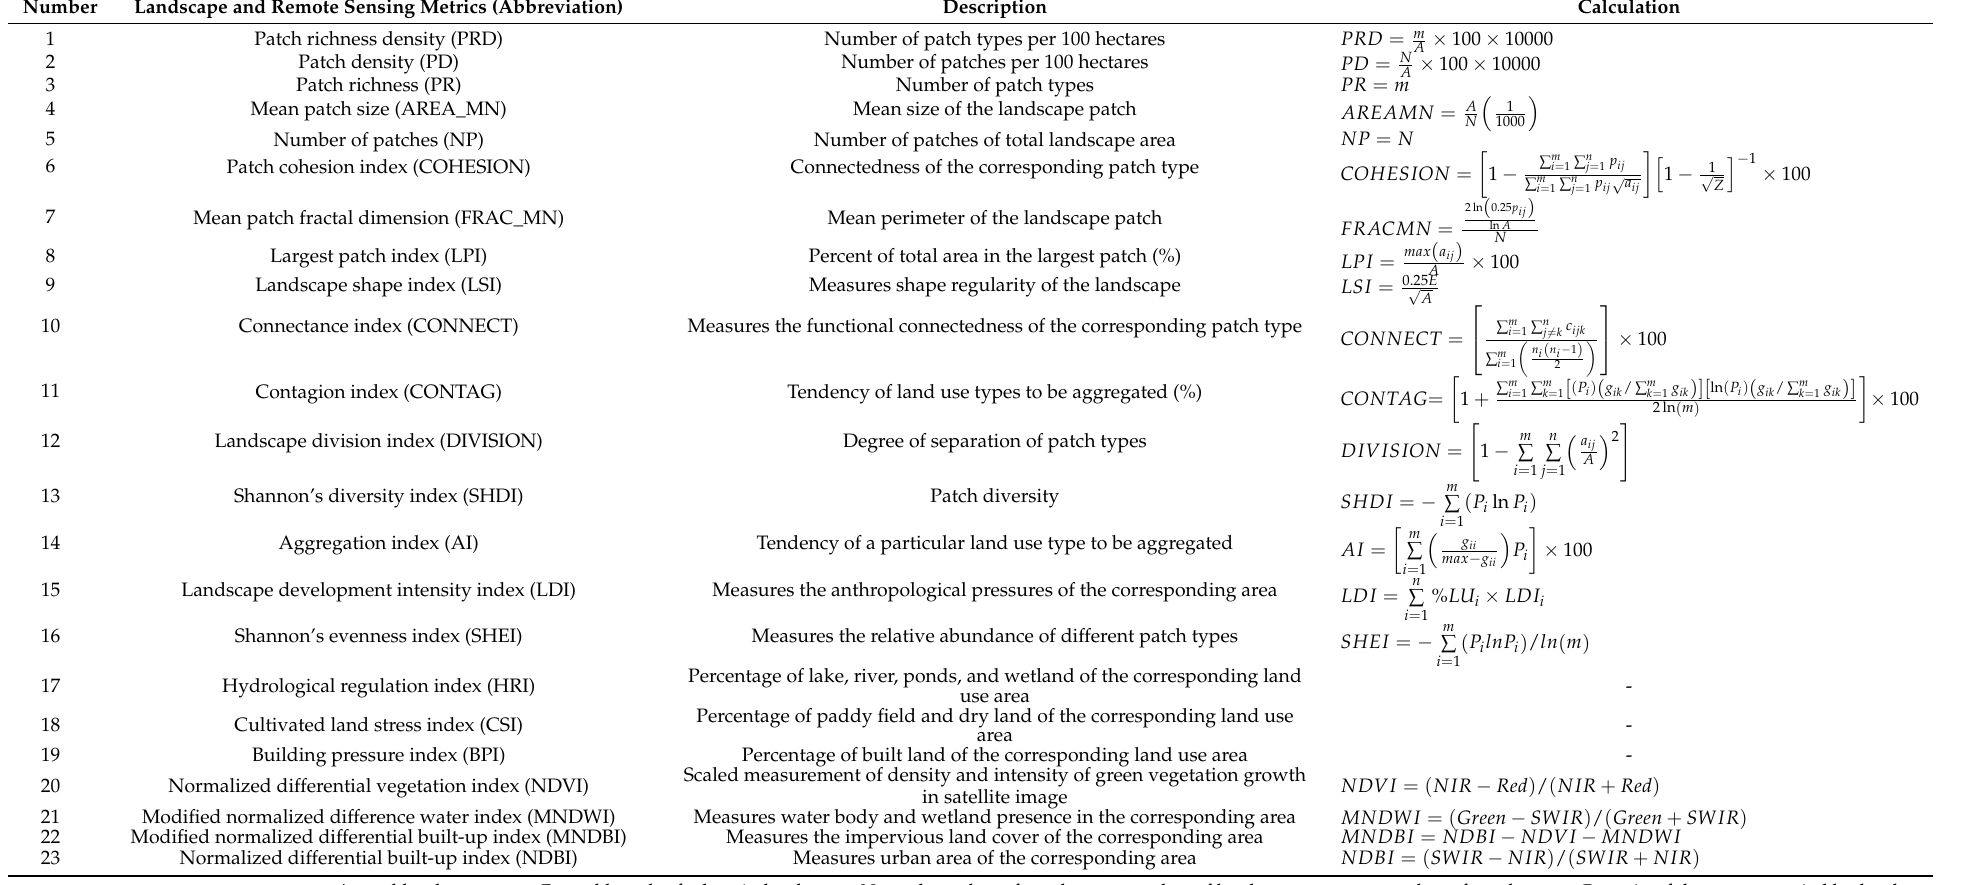
Table 1. Candidate landscape and remote sensing metrics for assessing the condition of the Poyang Lake